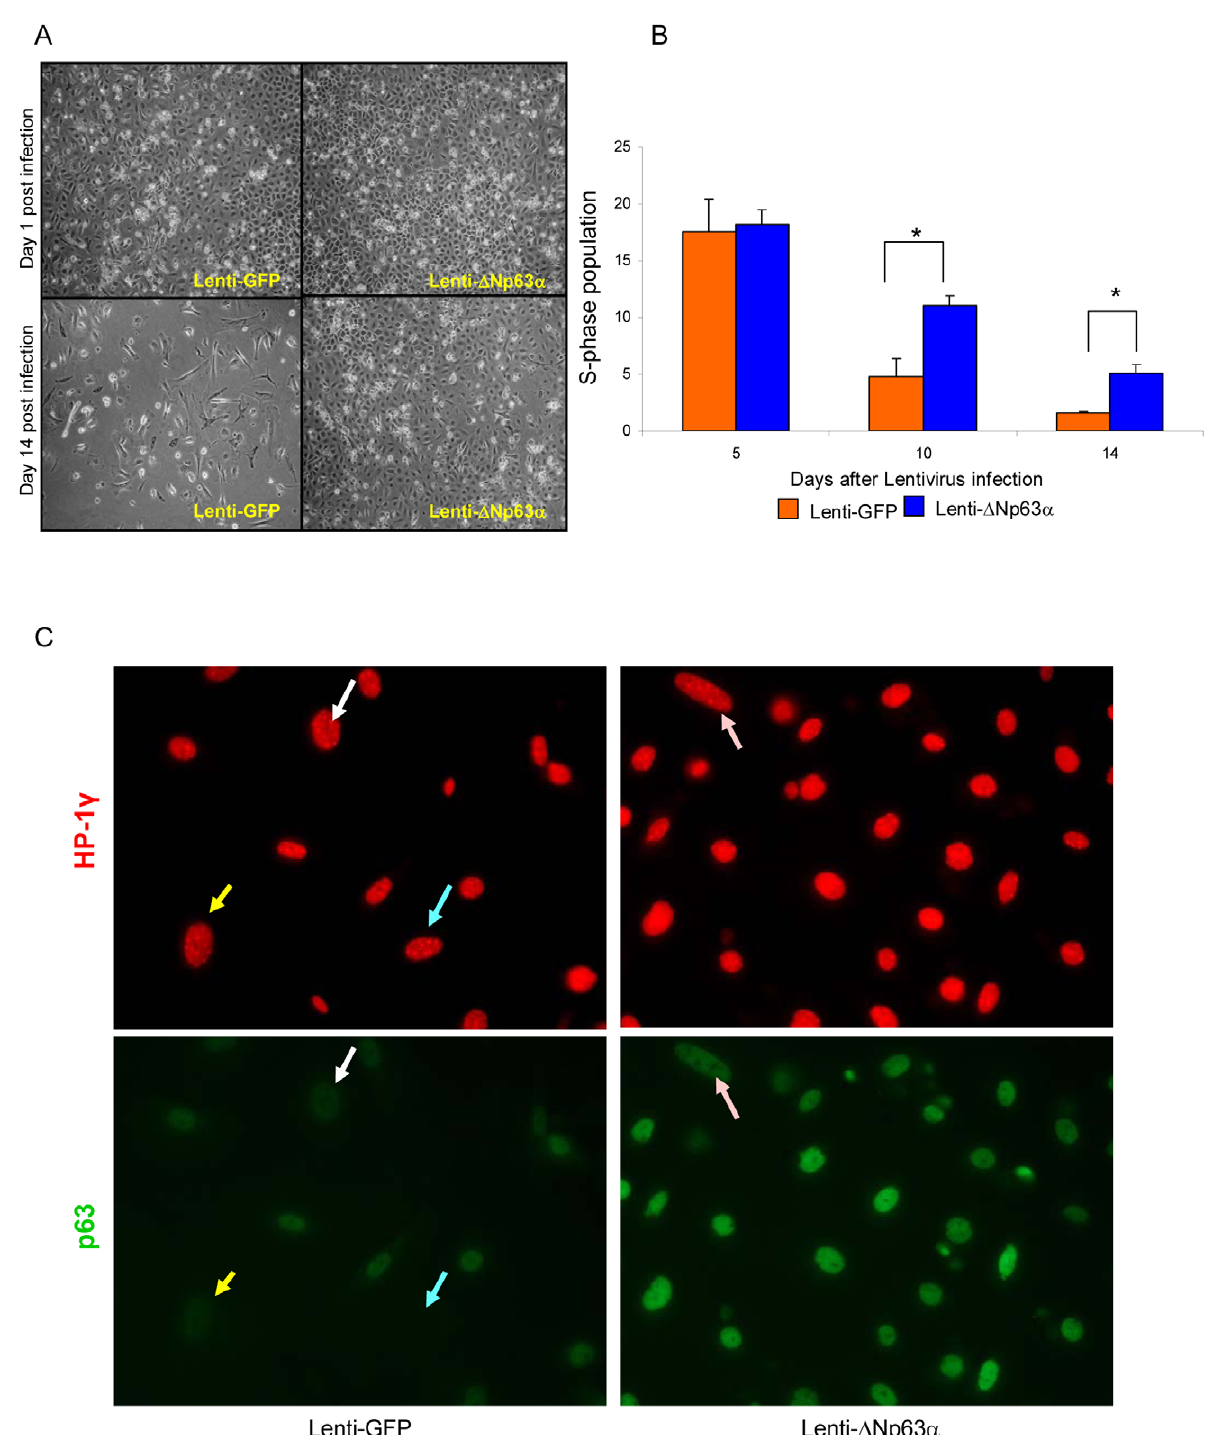
Figure 2. Dysregulated expression of D Np63 a promotes survival and blocks replicative senescence of primary keratinocytes. A, Phase morphology of lenti-GFP- and lenti- D Np63 a expressing keratinocytes cultured for 1 and 14 days post-infection. Results shown are representative of three independent experiments. B, Quantification of BrdU positive cells in lenti-GFP or lenti- D Np63 a cultures at timepoints noted following lentiviral gene transduction. Data shown represent the means 6 S.E. of three independent experiments. * indicates a statistically significant difference between lenti-GFP and lenti- D Np63 a infected cells at p , 0.05. C, Primary keratinocytes expressing lenti-GFP (left panel) or lenti- D Np63 a (right panel) were fixed at 14 days post-lentiviral transduction. The cell senescence status was assessed by the presence of HP-1 c nuclear foci (red). The cells were double stained with p63 antibodies (green). Matched arrows indicate the same cell stained with both different antibodies. The image presented is representative of three independent experiments.